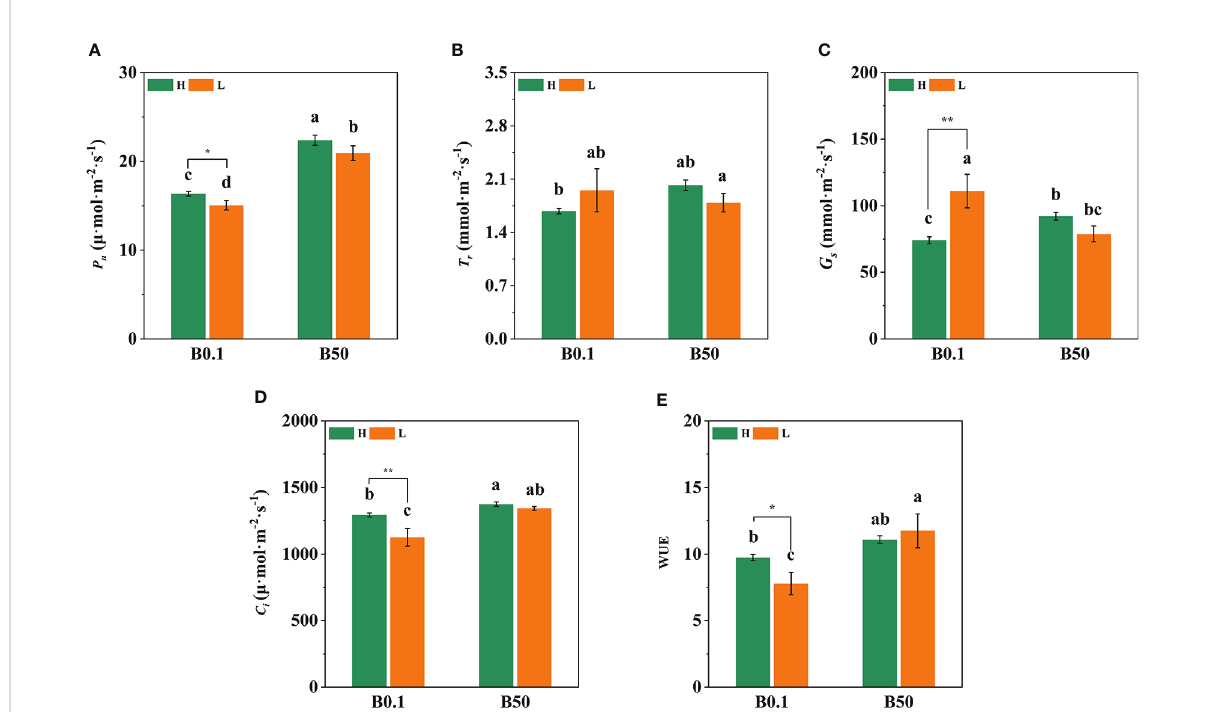
FIGURE 2 Effect of photosynthesis parameters in KWS1197 and KWS0143 cultivars. The seedlings were treated with B de fi cient (0.1 m M H 3 BO 3 , B0.1) and B suf fi cient (50 m M H 3 BO 3 , B50). P n is the net photosynthetic rate (A) , T r is the transpiration rate (B) , G s is the stomatal conductance (C) , C i is the intercellular CO 2 concentration (D) and WUE is the water use ef fi ciency (E) . Different lowercase letters (a, b, c) indicated signi fi cant differences between different treatment. Bars denote the mean (n=3) and error bars the standard